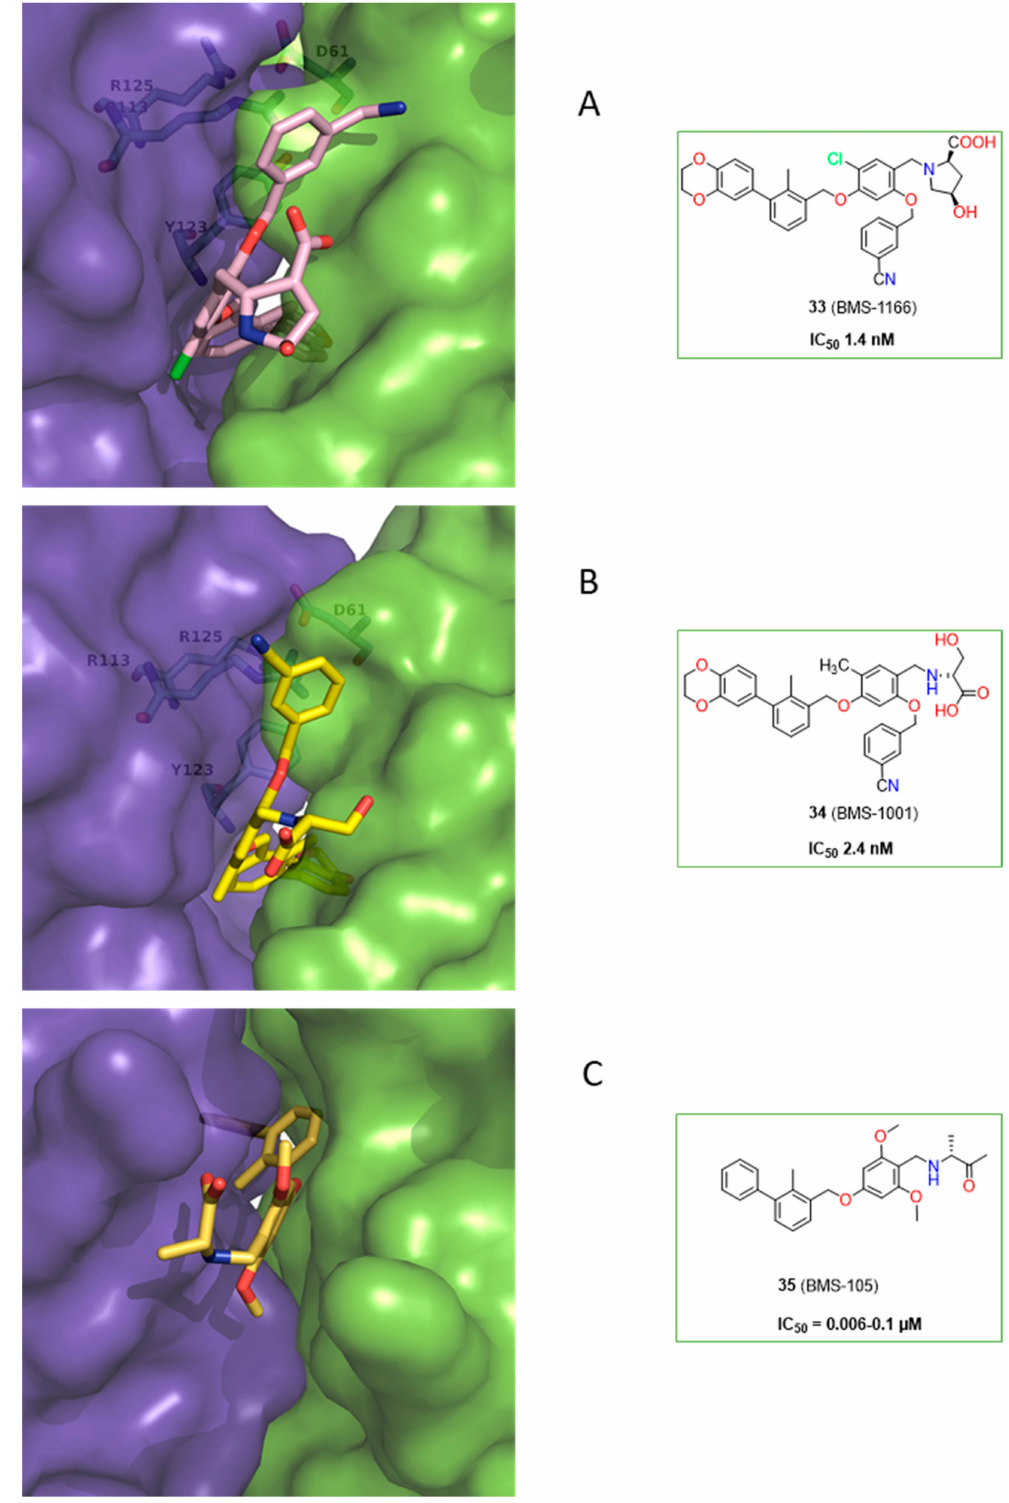
Figure 16. Examples of the BMS class compounds, for which structural data were provided. (A , B ) 2,3-dihydro-1,4-benzodioxine group of 33 and 34 induced transformation of the binding pocket into the binding tunnel across the transverse vertical axis of the dimer. Both compounds trigger formation of a subpocket binding the benzonitrile moiety [41,43,44]. ( C ) The binding cleft of 35 is closed from one side by the A Y56 residue. The arrangement of this inhibitor follows patterns for compounds 26 , 30 , and 31